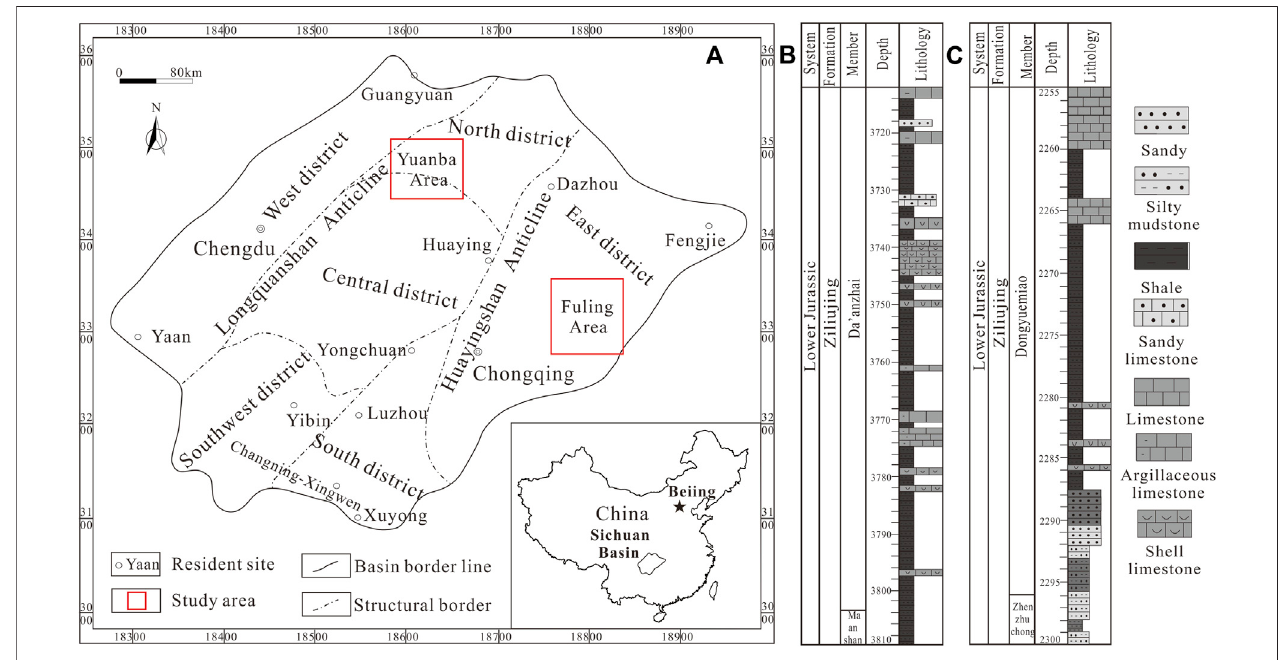
FIGURE 1 | Geological background (A) and stratigraphic sequence column map (B,C)